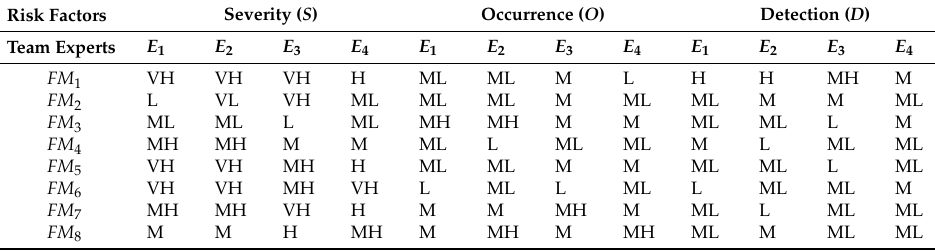
Table 3. Assessment information on the eight failure modes by FMEA team